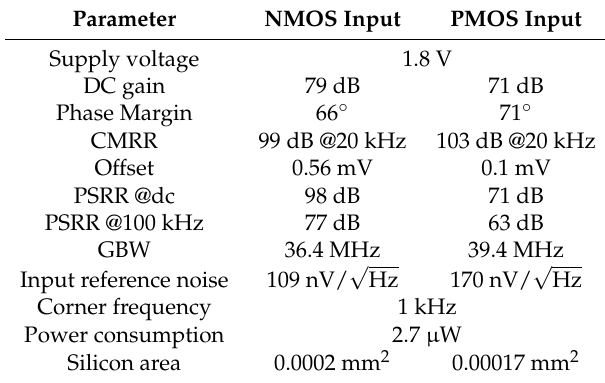
Table 1. Amplifiers parameters A 1 , A 2 and A 3 used in the proposed implementation.